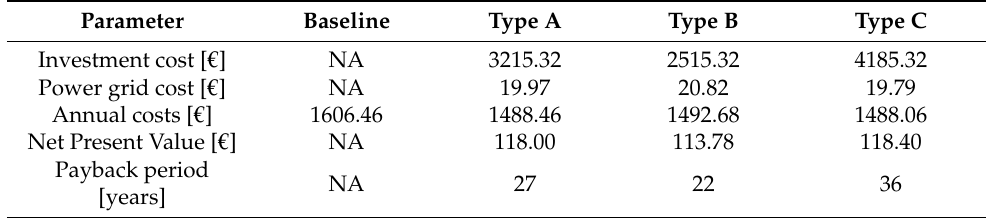
Table 5. Economic